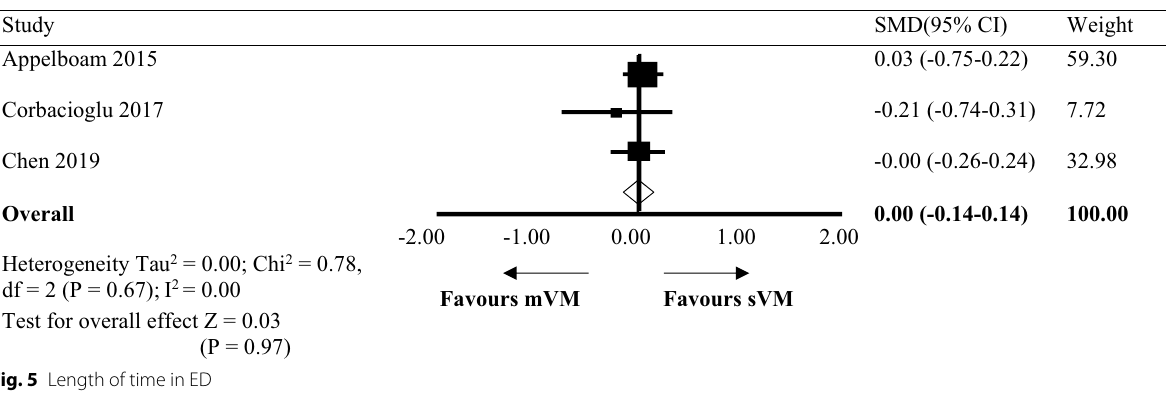
Fig. 5 Length of time in